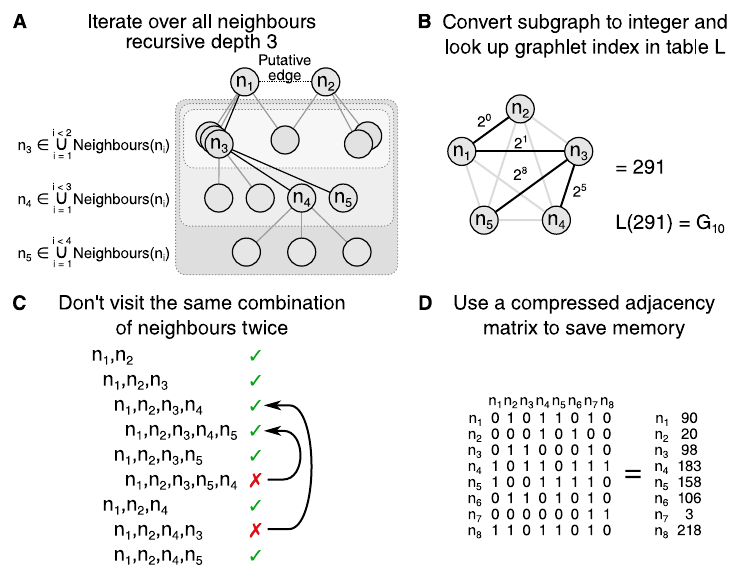
(B) A lookup table can be used to easily look up the graphlet index of a subgraph, by weighing each edge in a 5-node subgraph by a power of 2. (C) The same combination of five nodes is never repeated, as to avoid counting the same graphlet multiple times. (D) The adjacency matrix of the network is compressed in order to reduce memory